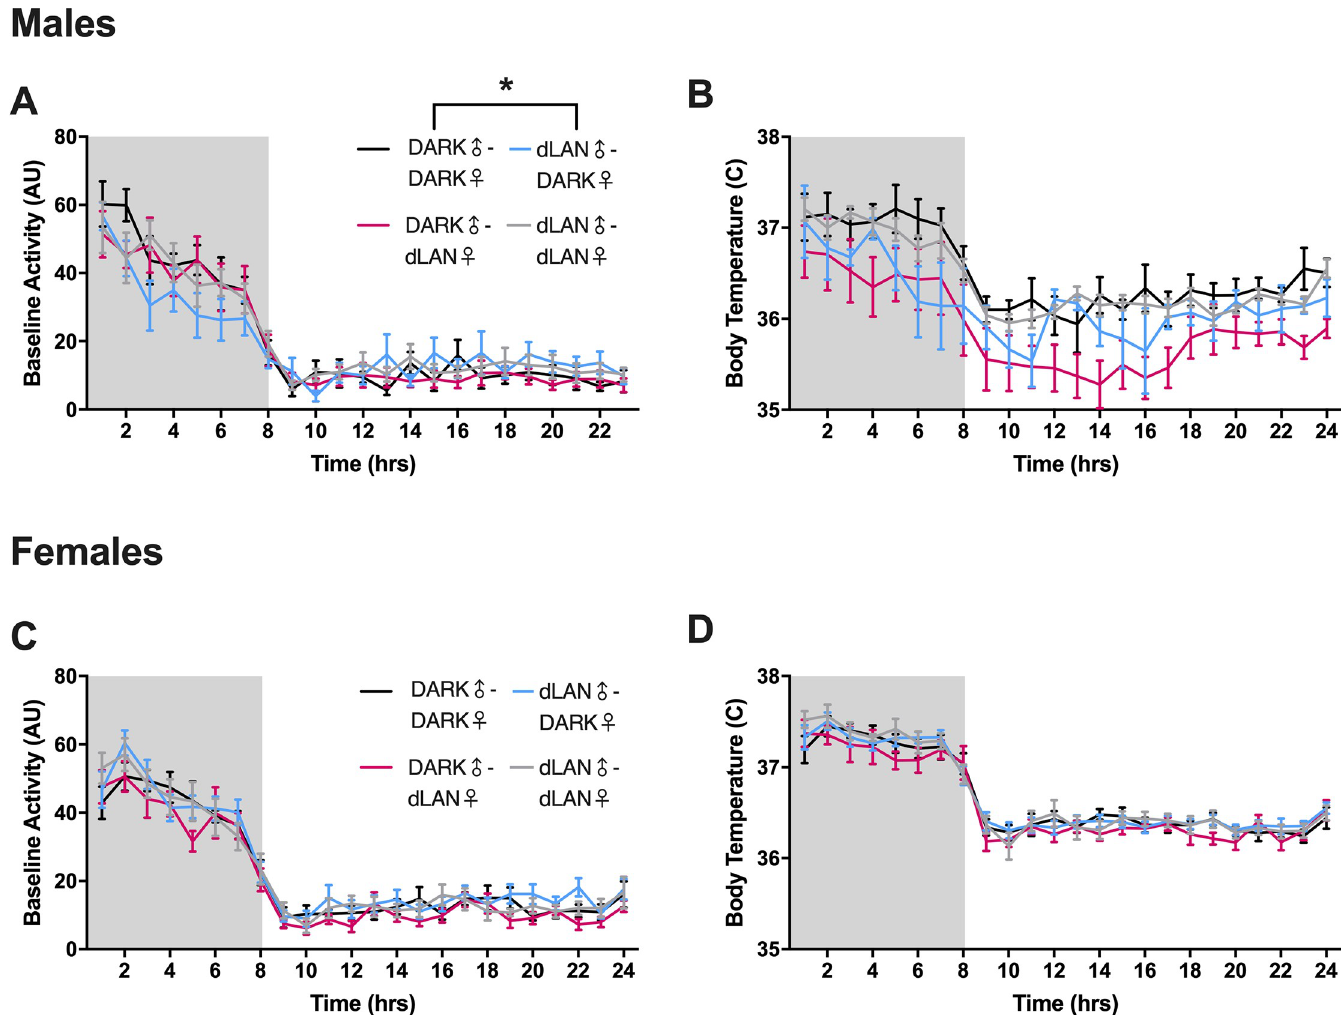
Fig 1. Male offspring of sires exposed to dLAN dampened locomotor activity rhythm amplitude. Homecage locomotor activity and body temperature rhythms in male (A,B), and female (C,D) offspring. N = 4-7/ group; error bars represent SEM. � , P < 0.05 Dark-Dark vs dLAN-Dark.